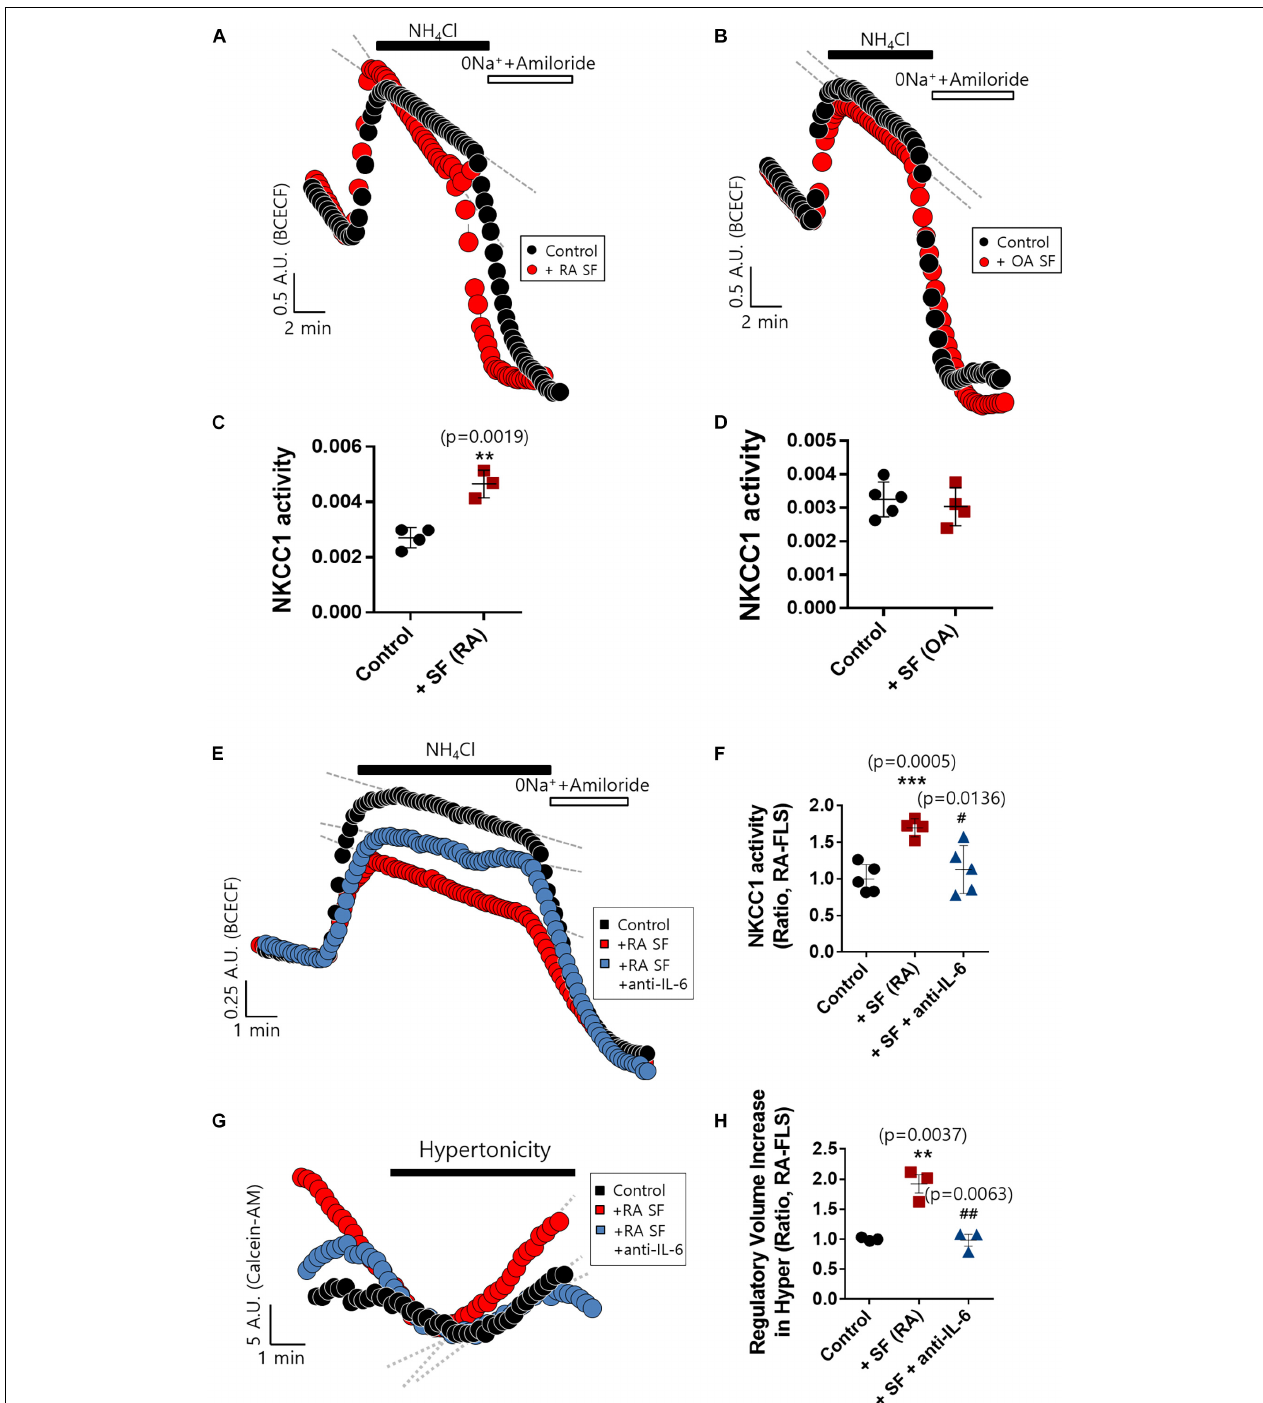
FIGURE 5 | Rheumatoid arthritis (RA) synovial fluid enhanced sodium–potassium–chloride cotransporter1 (NKCC1) activity and interleukin (IL)-6 antibody blocked the effect of RA synovial fluid in RA fibroblast-like synoviocytes (RA-FLS). NKCC1 activity was measured using the membrane of a Boyden Transwell chamber with pretreatment with (A) RA and (B) osteoarthritis (OA) synovial fluid for 6 h in RA-FLS. The bars represent the mean ± SEM of NKCC1 activity with or without (C) RA [ n = 4, ** p < 0.01, *: Control vs + SF (RA)] and (D) OA synovial fluid in RA-FLS. (E) NKCC1 activity by the stimulation of RA synovial fluid with or without 5 µ g/ml anti-IL-6 antibody for 6 h in RA-FLS on the membrane of Boyden Transwell chamber. (F) The bars represent the mean ± SEM of NKCC1 activity [ n = 5, *** p < 0.001, and # p < 0.05, *: Control vs + SF (RA), #: + SF (RA) vs + SF + anti-(IL) − 6]. (G) Volume changes in RA-FLS on stimulation with a hypertonic solution (400 mOsm/L). RA synovial fluid was pre-treated with 5 µ g/ml anti-IL-6 antibody for 1 h and then stimulated to RA-FLS on the membrane of Boyden transwell chamber for 6 h. (H) The bars represent the mean ± SEM of volume changes. Hypertonic solution (hyper) [ n = 3, ** p < 0.01 and ## p < 0.01, *: Control vs + SF (RA), #: + SF (RA) vs + SF + anti-(IL) − 6].